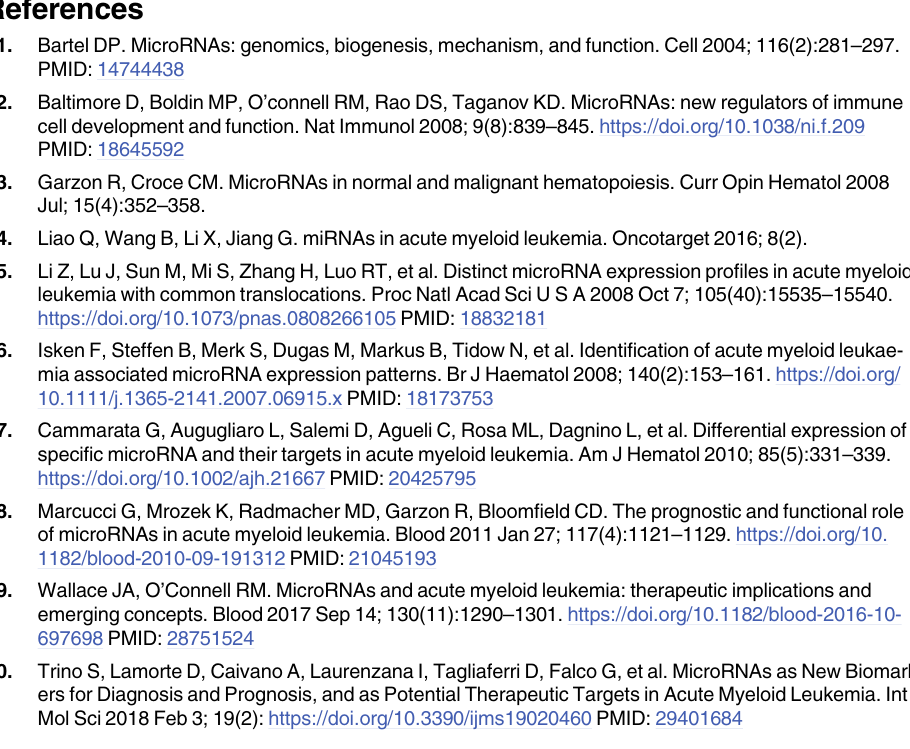
S1 Table. Differential expression of miRNAs in patients with NPM1+/FLT3+ AML versus control. This table shows the statistical analysis for each of 996 miRNAs for patients with NPM1+/FLT3+ AML versus normal controls. Results are listed in decreasing order of adjusted P.